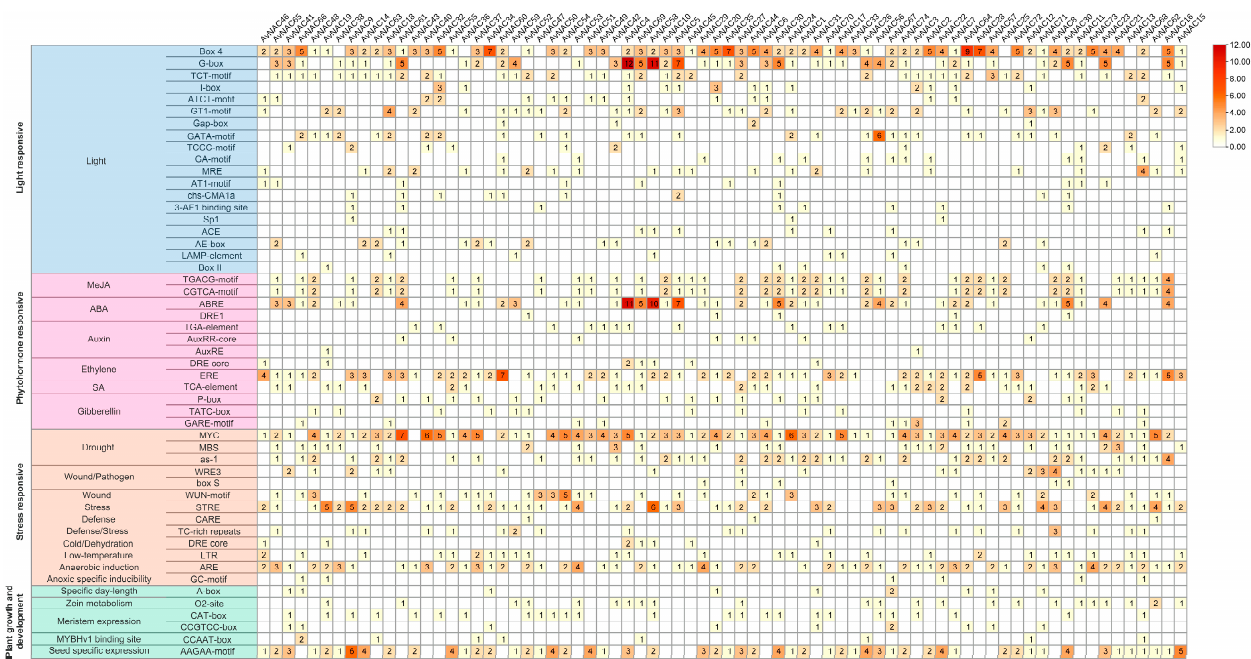
Figure 6. Analysis of cis -elements in AvNAC promoters. Statistics and categories of cis -elements in the promoter regions of AvNAC genes. The numbers of cis -acting element were indicated by numbers and a color gradient.